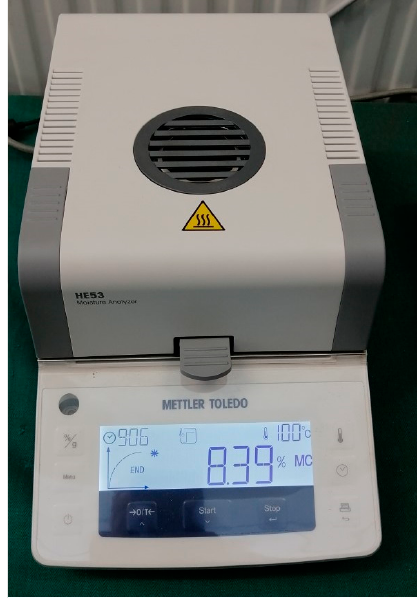
Figure 3. Moisture analyser HE53 230 V .